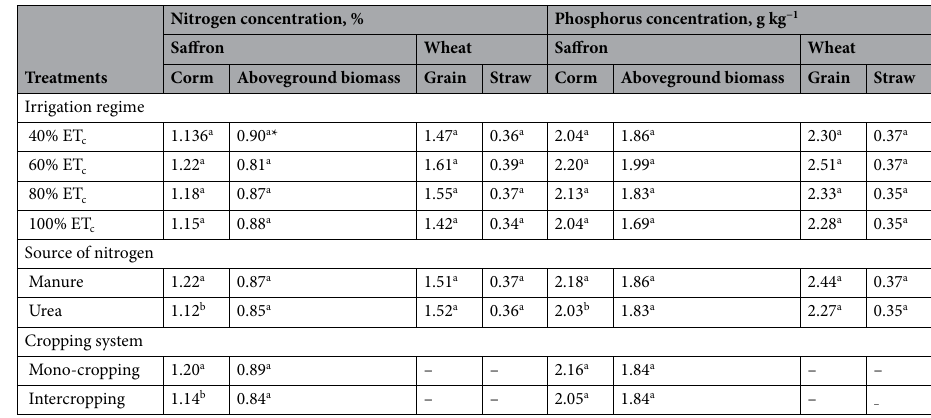
Table 6. Means for nitrogen and phosphorus concentration in the saffron and winter wheat organs for the last (fourth) growing season. *Means followed by similar letters in each column for each factor and each trait are not significantly different at 5% level of probability according to Tukey test.